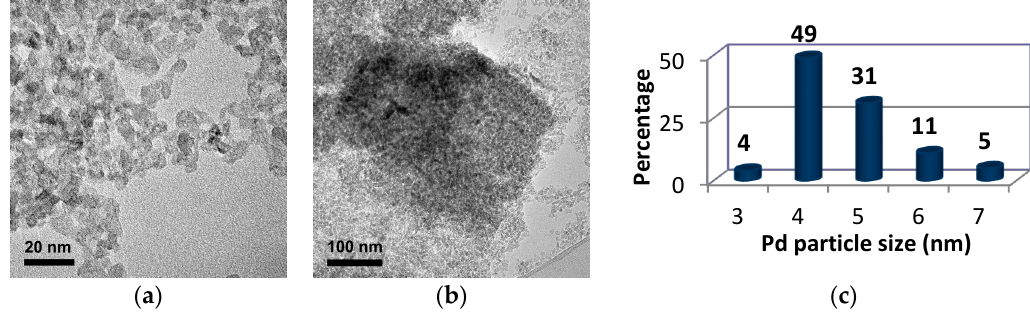
Figure 10. TEM pictures ( a , b ) and Pd NPs size distribution ( c ) for Pd/GO-TiO 2 .